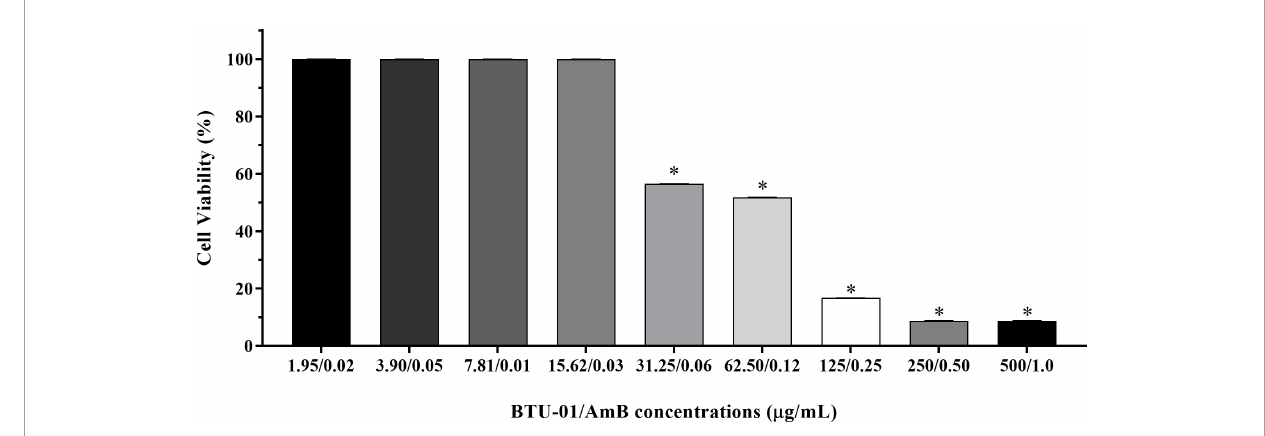
FIGURE7 Effect N -(butylcarbamothioyl) benzamide (BTU-01) combined with amphotericin B (AmB) on mammalian cell viability. HEp-2 CCL-23 cells were treated with different concentration combinations of BTU-01 and AmB (1.95–500.0 µ g/mL; 0.02–1.0 µ g/mL, respectively). Cell viability was measured by the MTT reduction assay after 48 h of incubation at 37 ◦ C. Values are mean ± standard deviation of three experiments. Asterisks indicate a significant reduction in the metabolic activity of treated cells compared to untreated ones ( ∗ p <